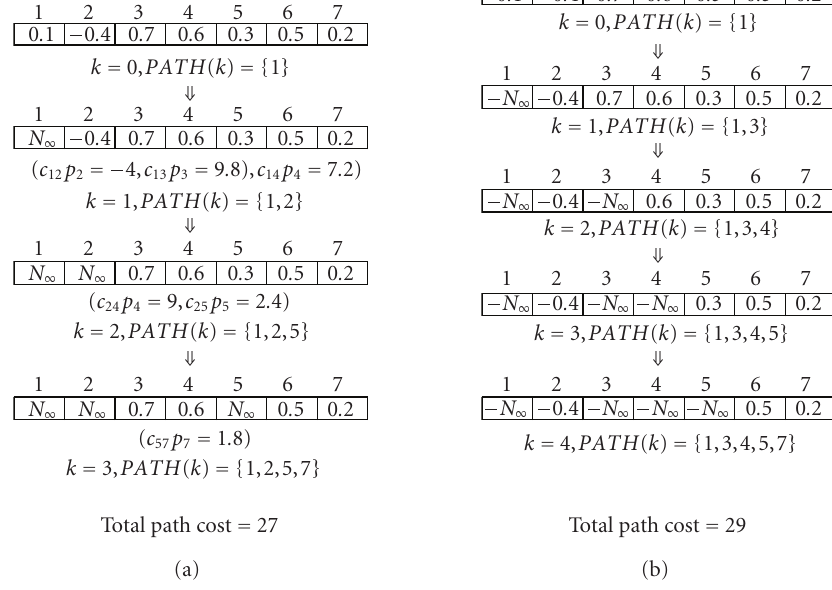
Figure 3.2 . Illustrative examples of path construction from a particle position/priority vector for the network of Algorithm 2.1: (a) proposed cost-priority-based decoding; (b) simple priority-based decoding